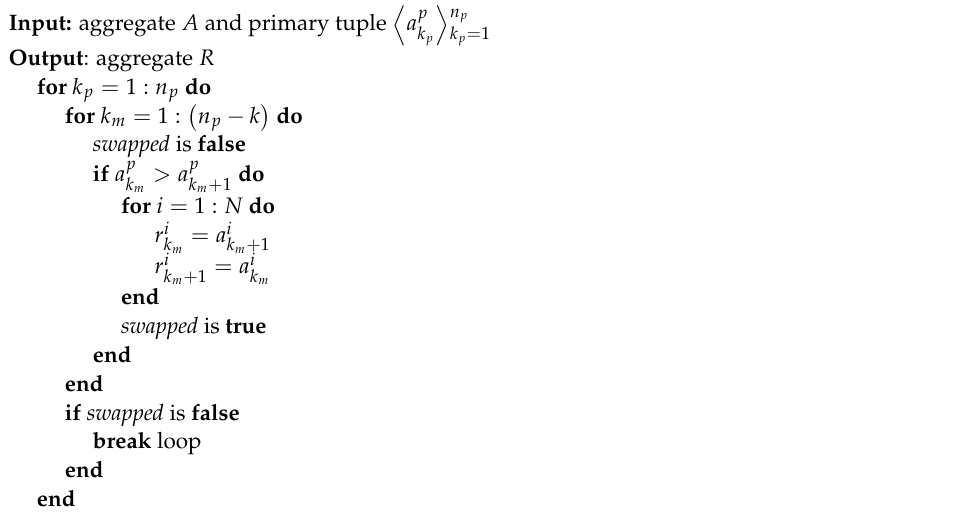
Figure 2. An example of two quasi-compatible aggregates.